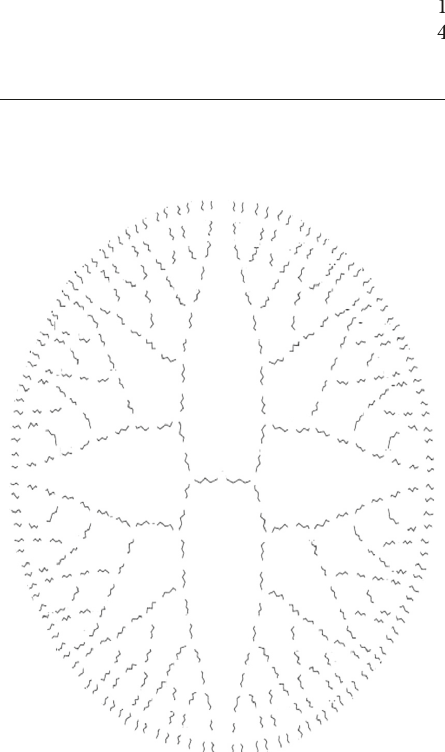
Figure 2: Propyl Ether Imine Dendrimer ( PETIM ) .